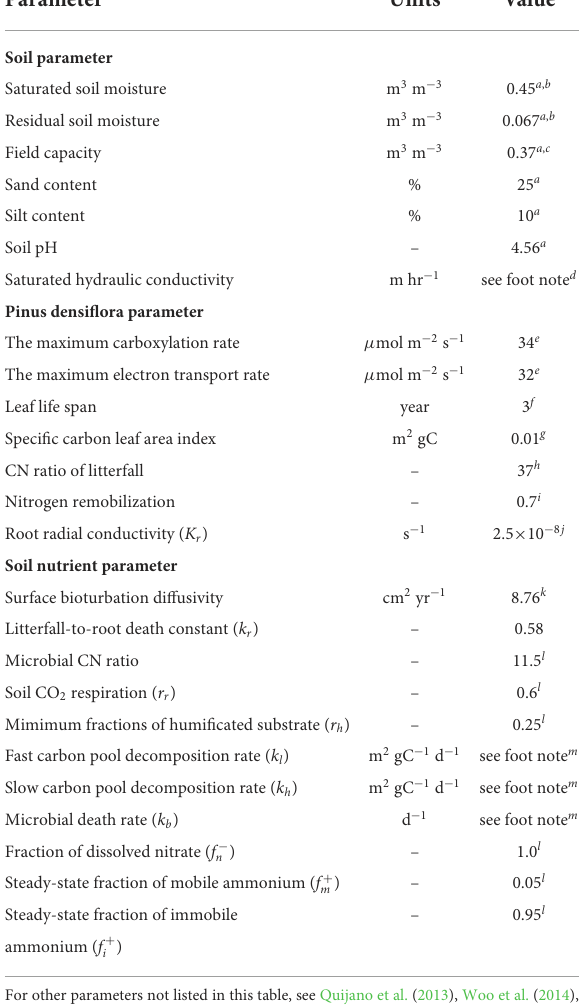
TABLE 1 Parameters used for the coupled ecohydrological and biogeochemical model.